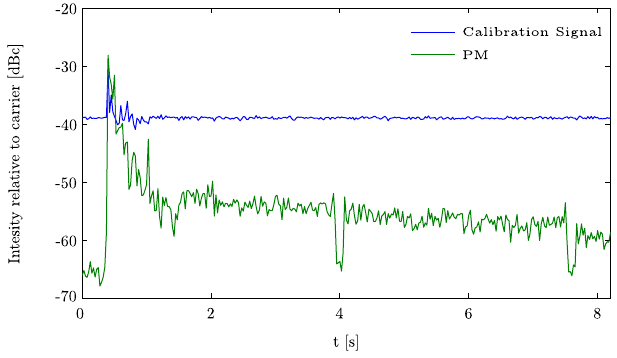
FIG. 8. Time development of the PM signal compared to a calibration signal after phase demodulation. The data were taken with the nominal LHC 25 ns beam of one batch at SPS flat